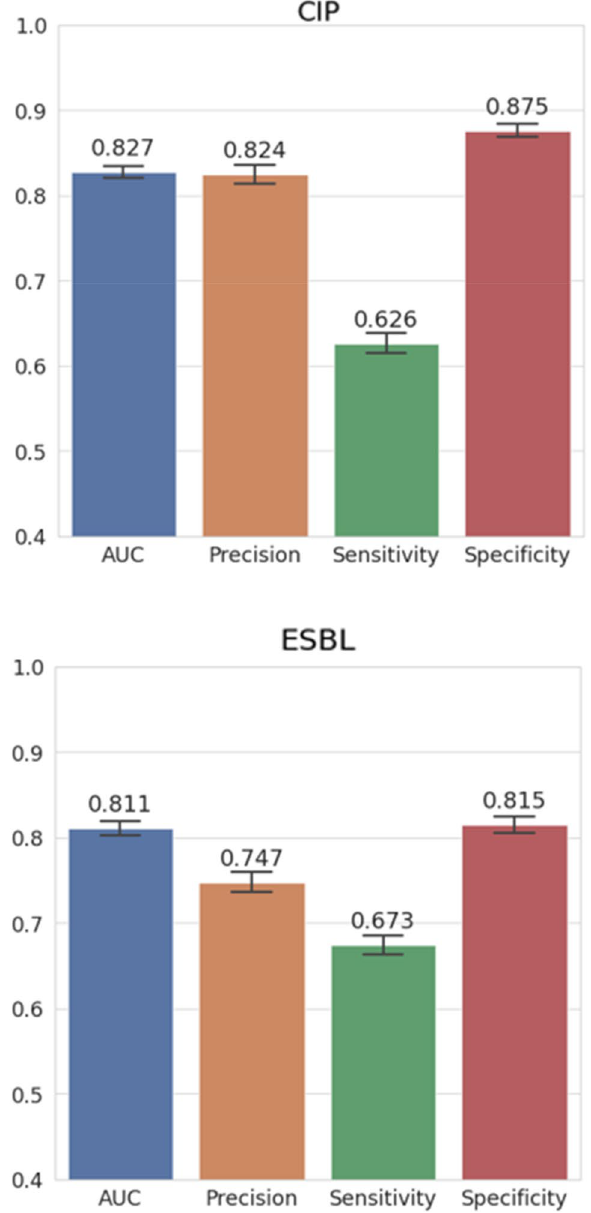
Figure 4. The classification performance of the Gradient-Boosted Decision Tree (GBDT). The decision threshold was set to 0.5 and 95% confidence intervals (error bars) were obtained by bootstrap